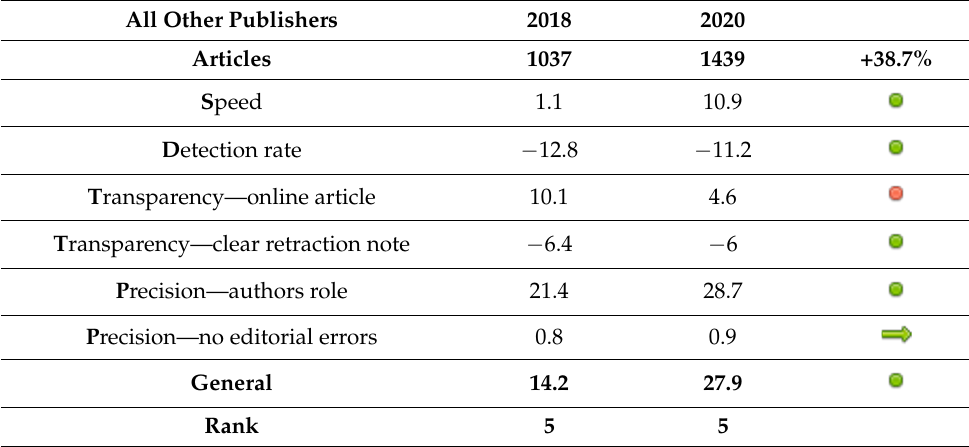
Table 15. Elsevier 2018 – 2020 change of SDTP score. Table 16. Springer Nature 2018 – 2020 change of SDTP score. Table 16. Springer Nature 2018 – 2020 change of SDTP score.